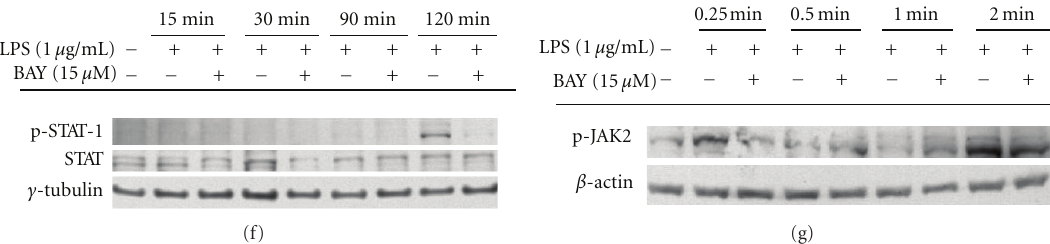
Figure 5: E ff ect of BAY on the activation of the IRF-3 pathway. (a left panel and b) Levels of NO by the Griess assay and PGE 2 by EIA from culture supernatants of RAW264.7 cell treated with BX795 (5 μ M) or AG490 (20 μ M) in the presence or absence of LPS (1 μ g/mL) for 24 h. (a right panel) Levels of COX-2 and iNOS mRNA by real-time PCR using LPS-treated RAW274.7 cells pretreated with BX795 (5 μ M) for 6h. (c, d, f, and g) Translocated or phosphorylated levels of IRF-3, STAT-1 or JAK2 from nucleus (c and f) or total lysates (d and g) from RAW264.7 cells treated with BAY (15 μ M) in the presence or absence of LPS (1 μ g/mL) for indicated times, evaluated by immunoblotting. (e) HEK293 cells cotransfected with IFN- β -promoter-1-Luc construct (1 μ g/mL) and β -gal (as a transfection control) were treated with BAY in the presence or absence of TBK1 (1 μ g/mL). Luciferase activity was measured using a luminometer. Relative intensity (c) was calculated by densitometric scanning. ∗ P < 0 . 05 and ∗∗ P < 0 . 01 compared to the